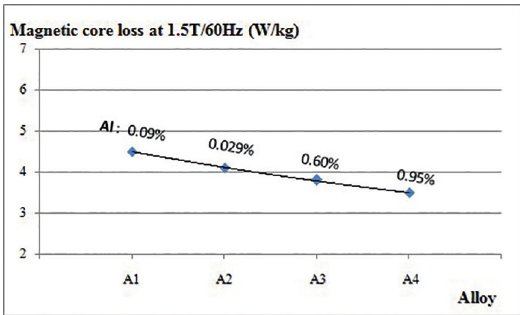
Figure 5: Variation of magnetic core loss in function of Al content.